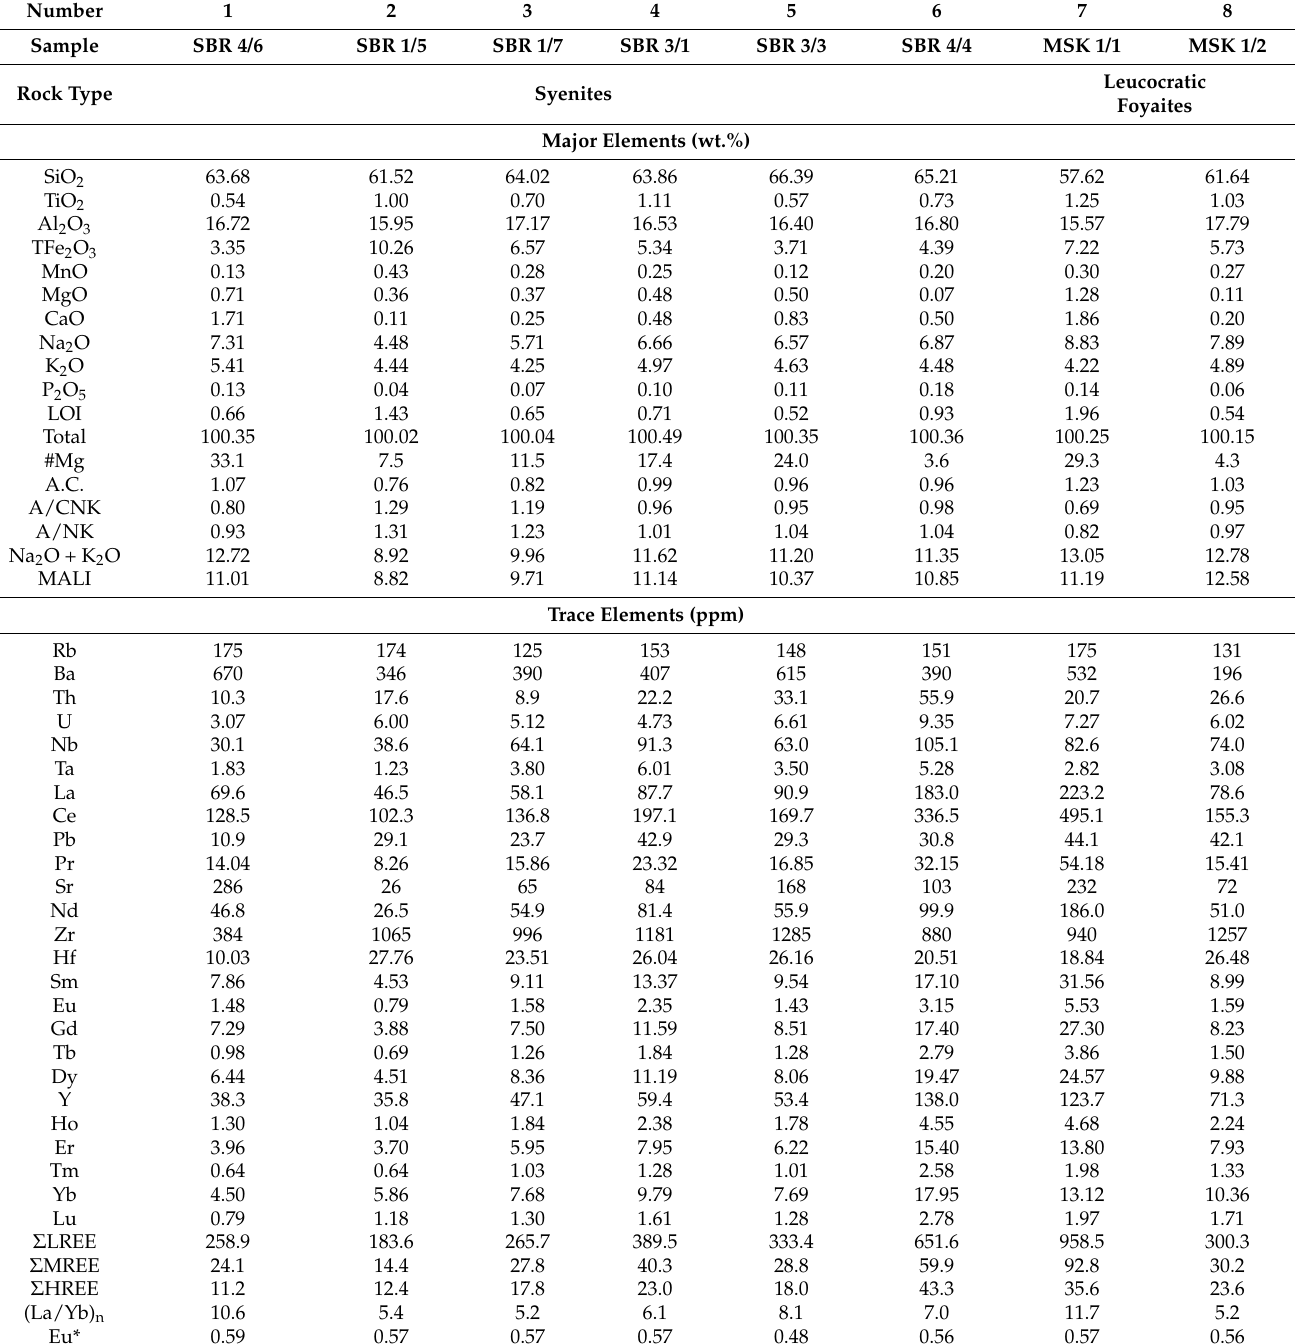
Table 2. Chemical composition of the Saibar